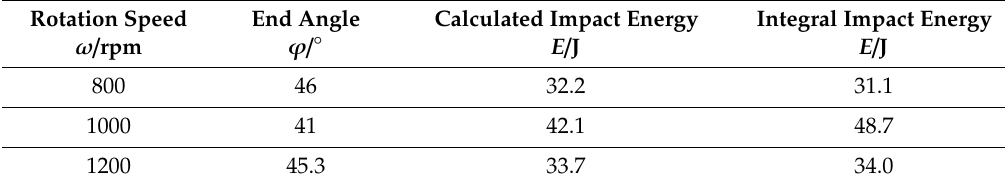
Table 3. The impact test parameters and the impact